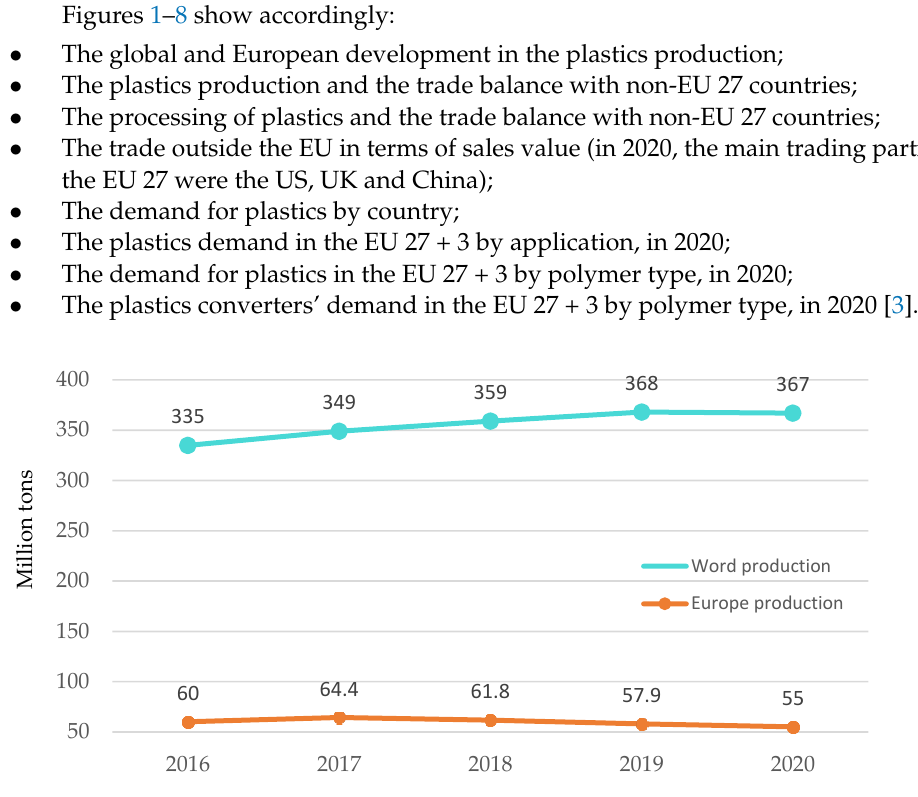
Figure 1. Worldwide and European development of plastics production. Made based on [3].